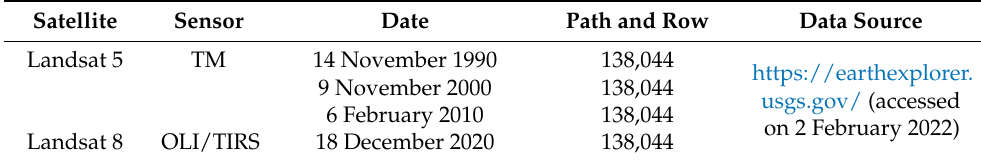
Table 1. Details of satellite data and acquisition